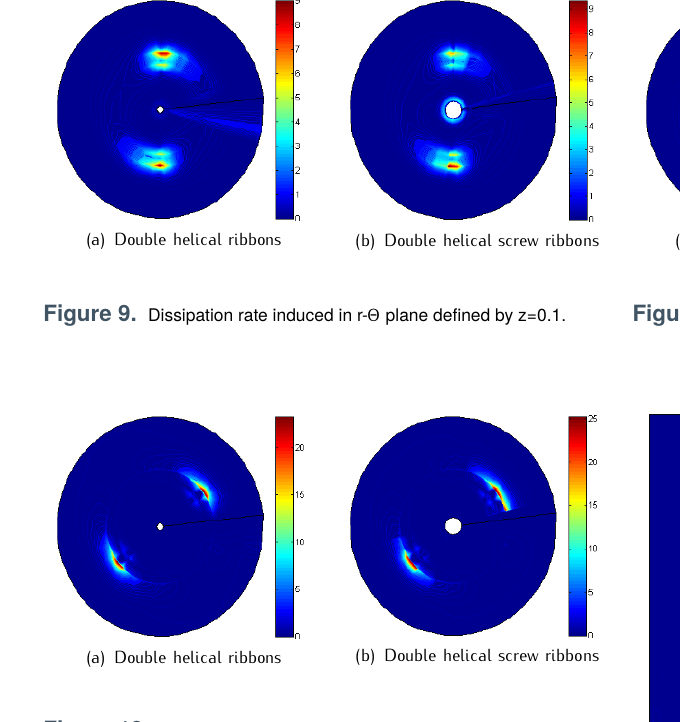
Θ plane defined by z=0.95.